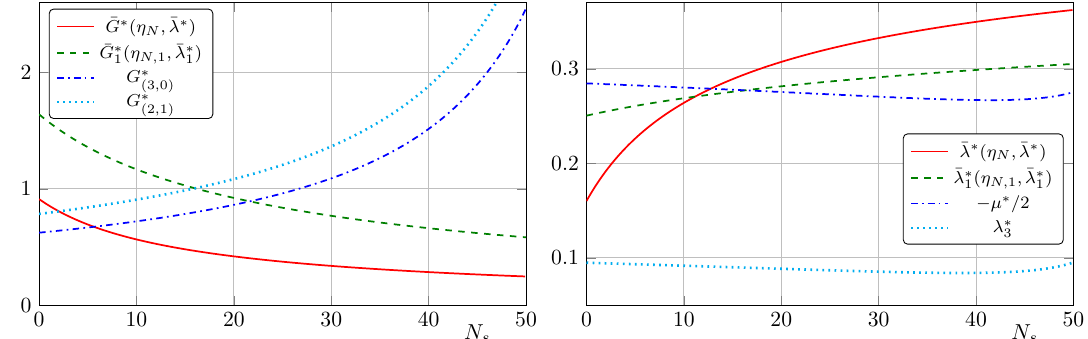
in the background-field s